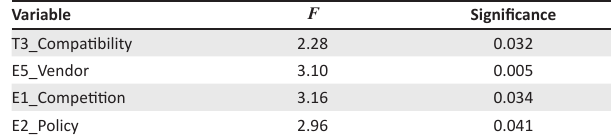
TABLE 2: Analysis of variance by